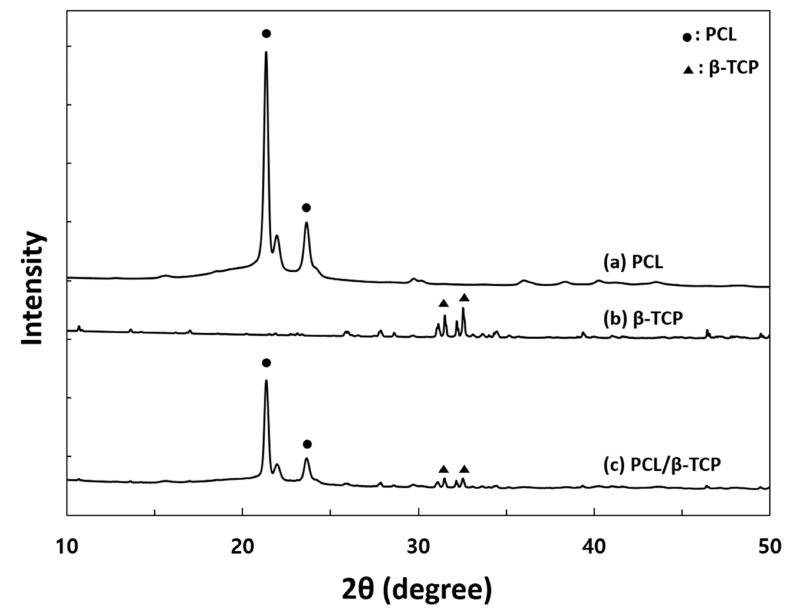
Figure 3. XRD patterns of: (a) PCL scaffold, (b) β -TCP powder, and (c) PCL/ β -TCP scaffolds.